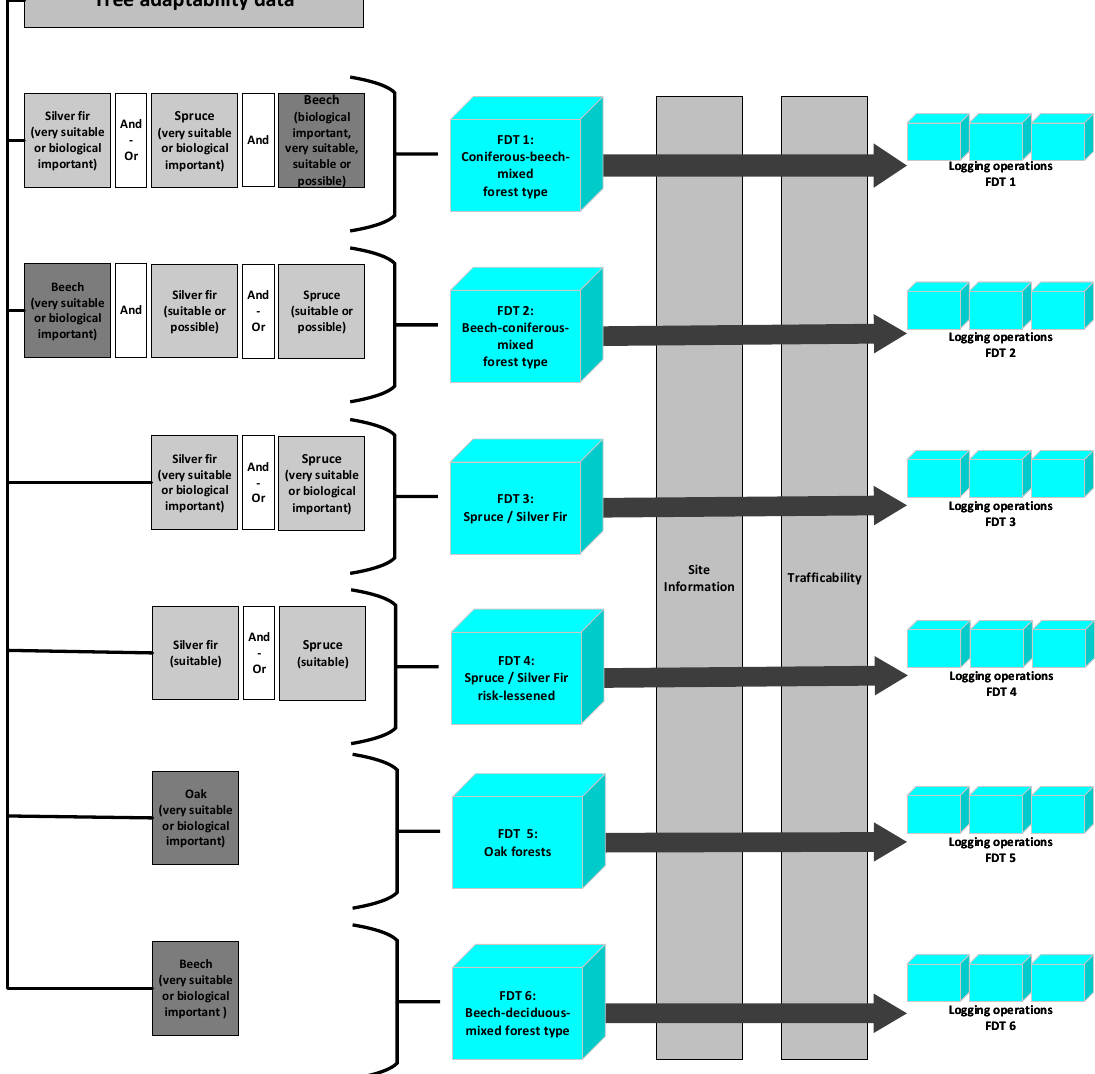
Figure 2. Flowchart of the Geographic Information System (GIS) analysis to determine Forest Development Types (FDTs) from species suitability data and timber harvesting and extraction operations from site information and trafficability data.